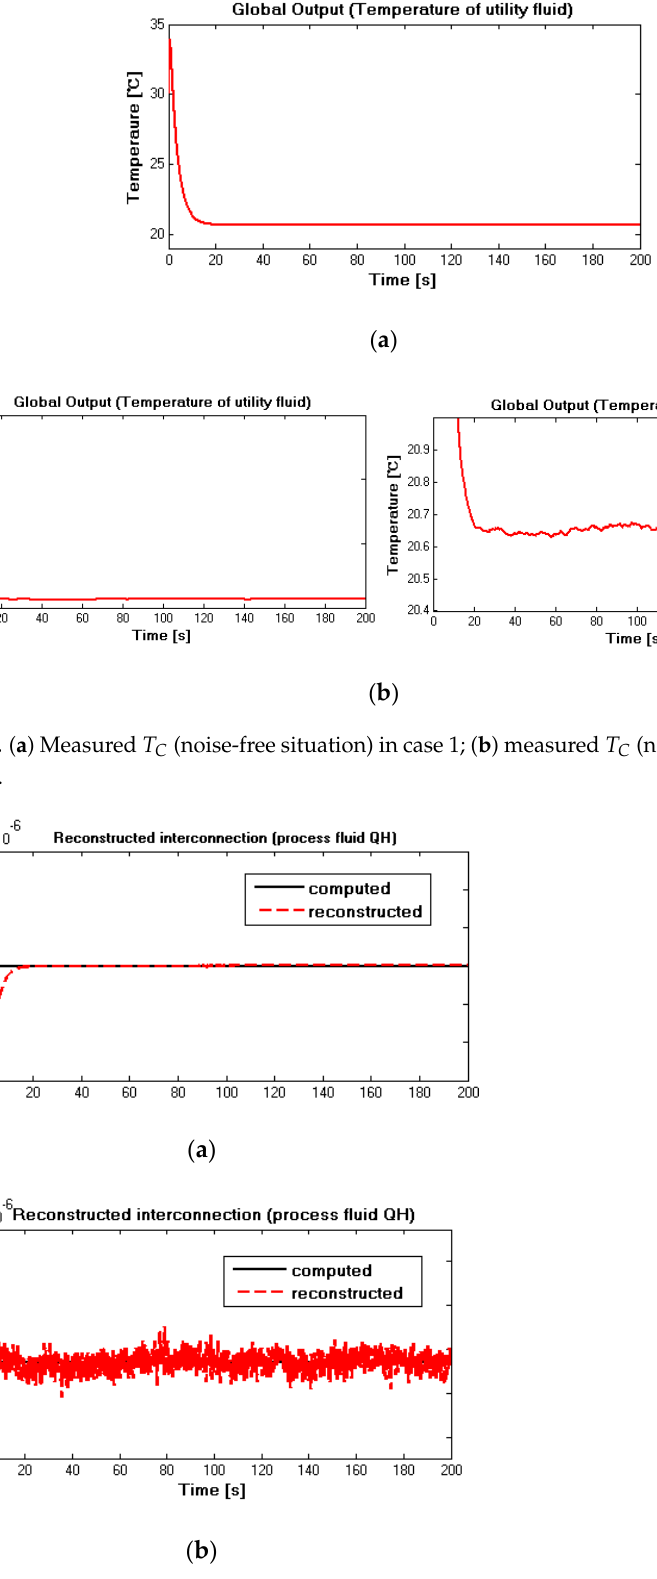
Figure 6. ( a ) Reconstructed and computed (cid:1843) (cid:3009) (noise-free situation) in case 1; ( b ) reconstructed and computed (cid:1843) (cid:3009) (noise-corrupted situation) in case 1. When it comes to the utility fluid case in Figure 7a,b, the computed value in black solid lines overlapped the reconstructed values in red dash lines after a short transient time, no matter with or without measurement noise. Figure 7a illustrates the noise-free case while Figure 7b represents the noise-corrupted situation. From Figure 7b, compared with measured temperature, it can be seen that noise value impacts reconstruct value more significantly. Whatever the case, the input reconfiguration capability of the high- level subsystem is confirmed. Thereafter, these reconstructed values were used as inputs of the inverse of the low-level subsystem, with the aim of checking the reconfiguration capacities.